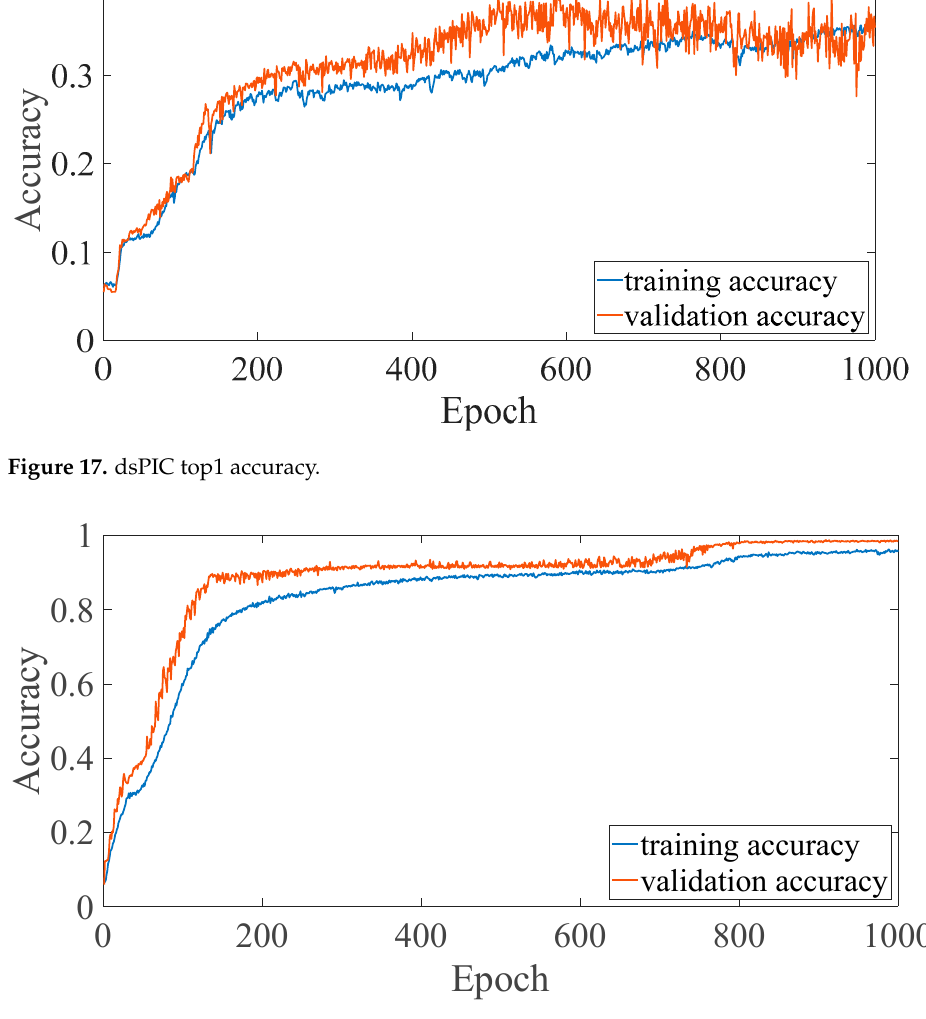
Figure 18. CPU0 top1 accuracy.